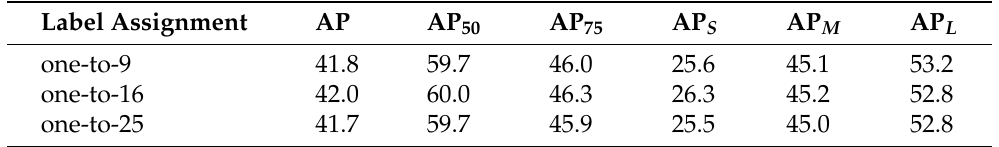
Figure 5. The ( a ) and ( b ) are diagrams of alternative architectures of objectiveness branch. The pink cubes represent convolutional layers. Table 8. Results of different settings of label assignment in objectiveness branch on COCO val2017 set. ‘One-to-K’ represents averagely assigning K number of positive samples to each GT instance.